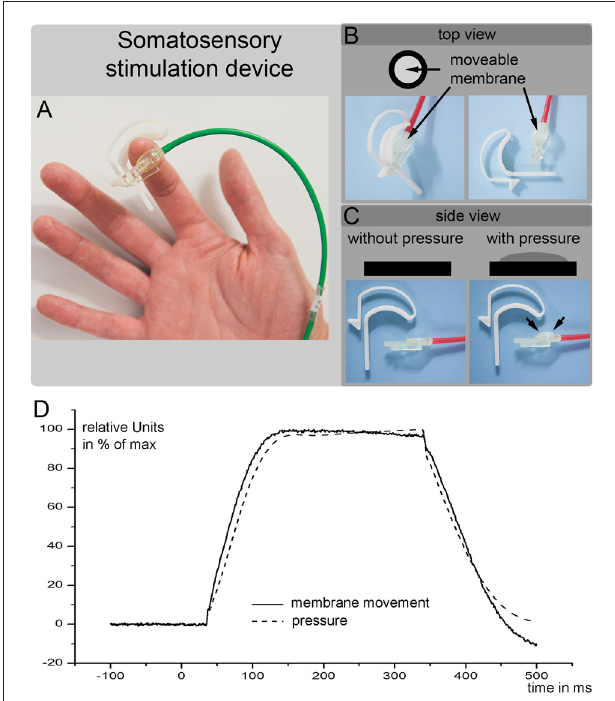
FIGURE 2 | (A–C) are a schematic outline of the somatosensory stimulation device used in the current study. (D) Shows the movement of the balloon diaphragm (solid line) and the changes in pressure (dotted line). The air pump was started at time 0 and required 40 ms increase the air pressure at the membrane. The y -axis shows the changes in the membrane position and changes in the pressure in relative units (maximal movement or pressure =